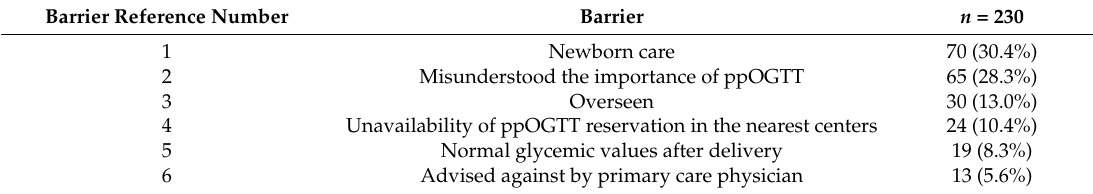
Table 2. Prominent barriers to